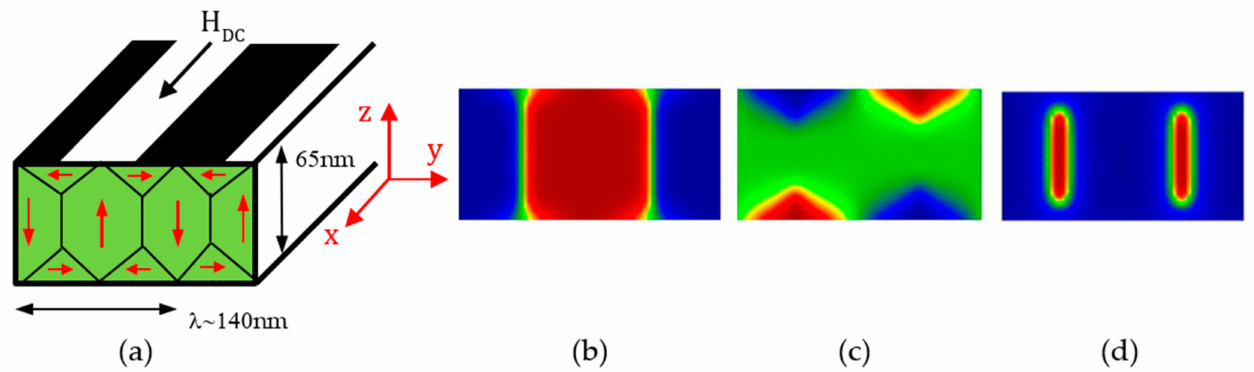
Figure 2. Sixty-five nm thick NdCo 5 remanent state: ( a ) reference axes, applied field direction and sketch of the stripe domain structure; ( b ) out-of-plane magnetization, in-plane components of the sample: ( c ) perpendicular; ( d ) parallel to the applied field H DC